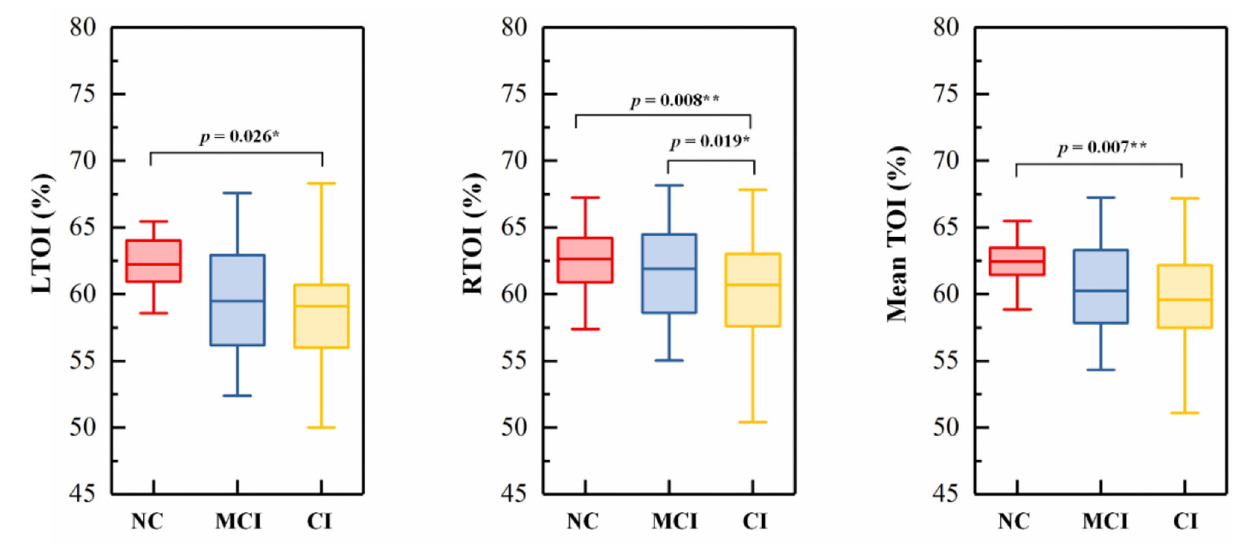
FIGURE 3 | Box-plots picturing the distributions of (A) LTOI, (B) RTOI, and (C) mean TOI. In each boxplot, the NC group (NC) is indicated by red rectangles, the MCI group (MCI) by blue rectangles, and the CI group (CI) by yellow rectangles. The line connectors on the tops of individual panels indicate cases where the difference between two boxplot distributions was statistically significant. p < 0.05 are marked with *, p < 0.0167 are marked with **.